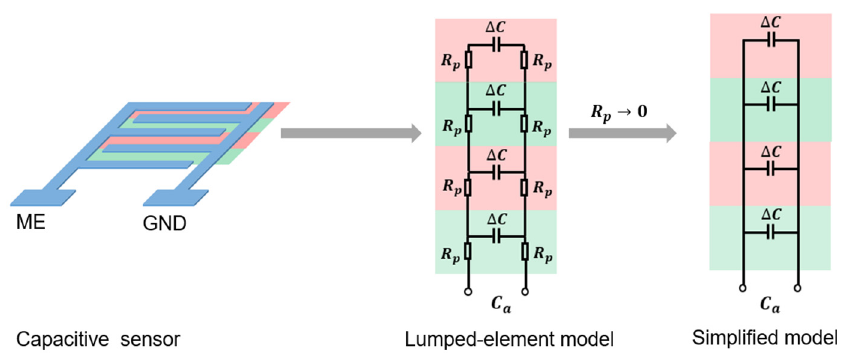
Figure 1. Lumped-element model of capacitive sensing and its relation with the resistance.